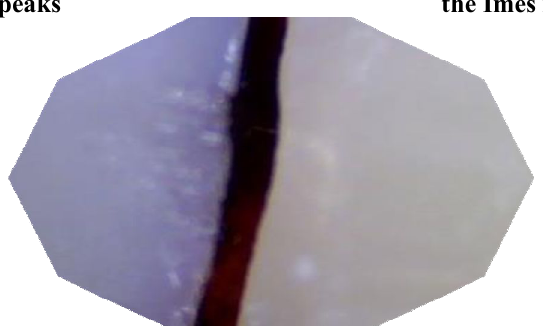
Figure 12: Enlarged photo of marginal gap Figure 13: Enlarged photo of marginal gap of